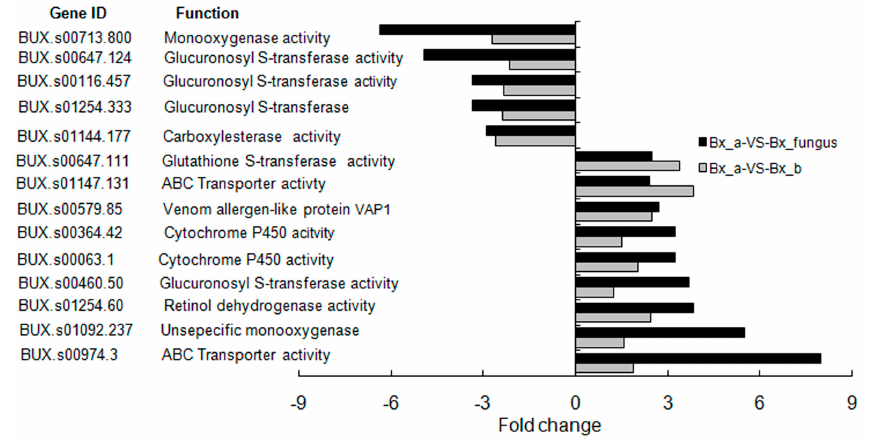
Figure 3. Putative detoxification-related genes most differentially expressed, with higher levels in B. xylophilus treated with S. maltophilia NSPmBx03 and fungus B. xylophilus . Bx_a: aseptic B. xylophilus , Bx_b: B. xylophilus treated with S. maltophilia NSPmBx03, Bx_fungus: fungus B. xylophilus . The left of the vertical axis indicates down-regulated genes, and the right indicates up-regulated genes.